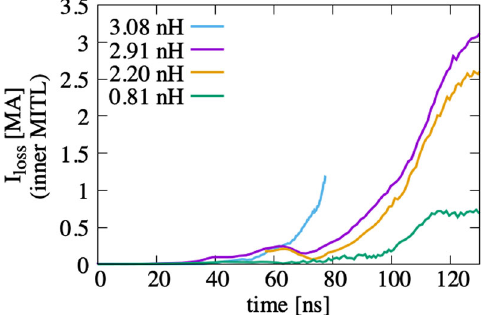
FIG. 14. The net current shunted across the AK gap in the inner MITL ( I ) from simulations of four inner MITL geometries loss identified by their load ( r ≤ 1 . 3 cm)